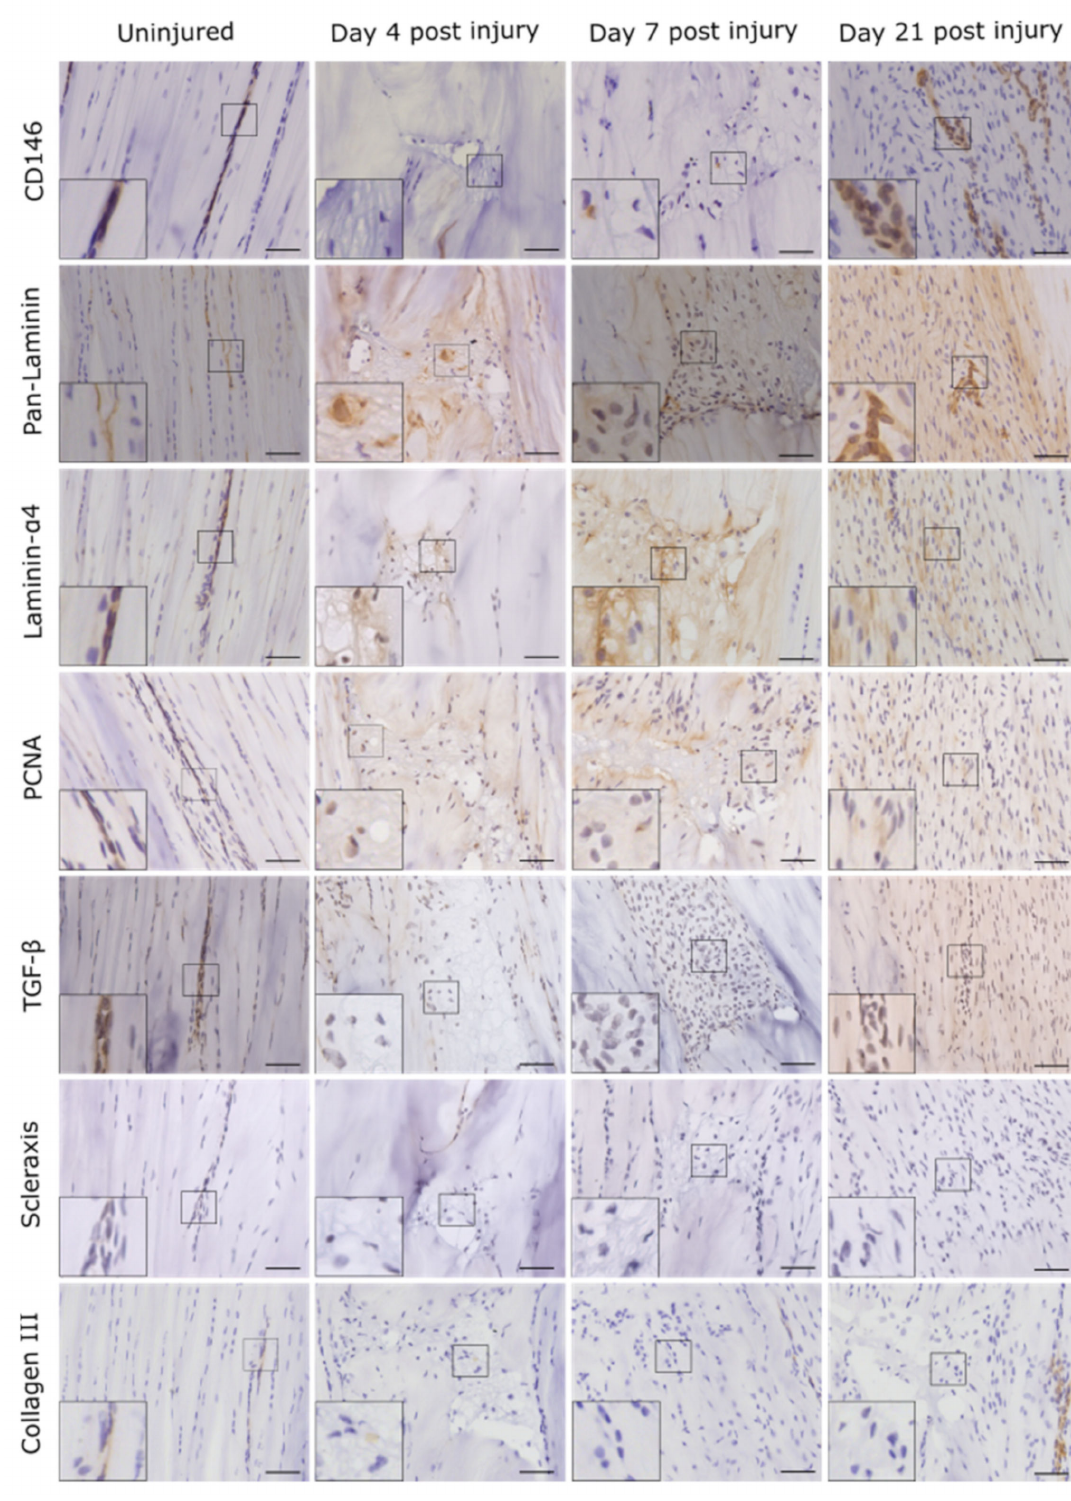
Figure 2. Injury response over time was assessed using immunohistochemistry for a panel of markers. Images show the lesion site in injured tendons and the corresponding region in uninjured tendons. Positive staining is brown, with cell nuclei counterstained blue. Inset shows the region of interest magnified 2.5 times. Scale bar = 50 µ